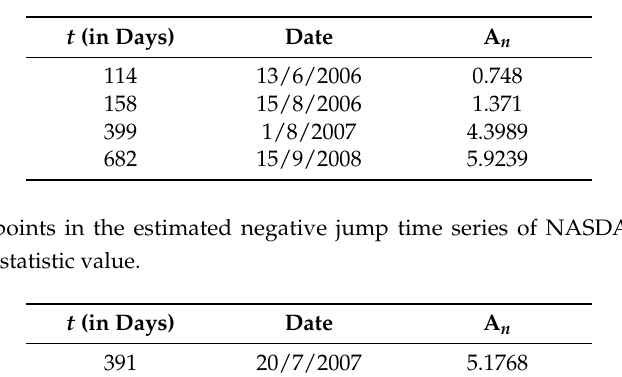
Figure 4. Change points in the estimated bivariate jump time series of NASDAQ.